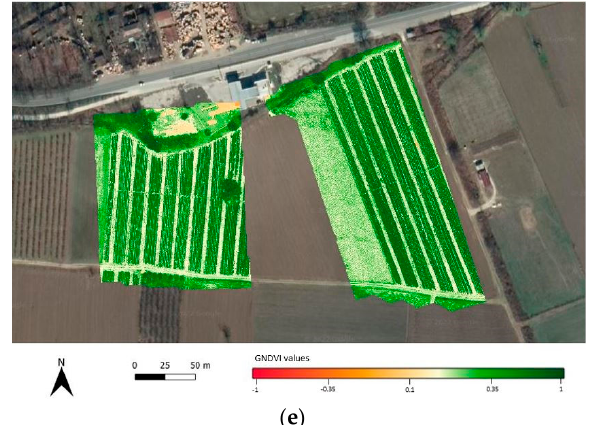
Figure A3. Maps of the biophysical parameters for Katunica, Bulgaria pepper field retrieved from